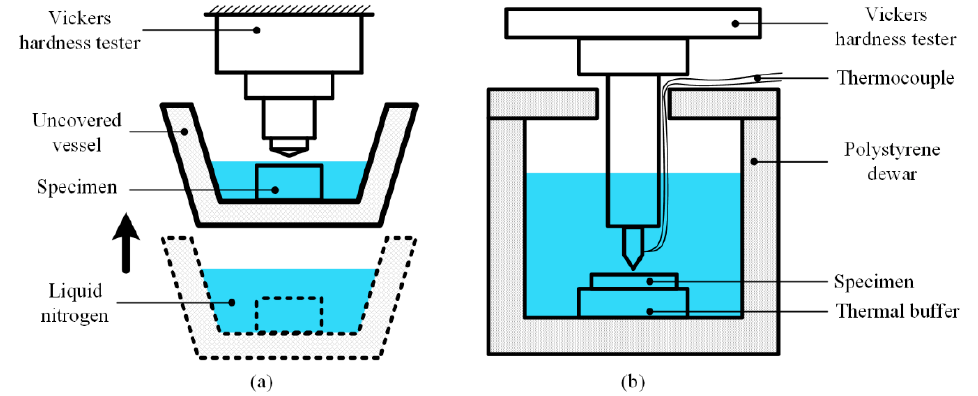
Figure 6. Schematic diagram of indentation test immersed in liquid nitrogen (LN 2 ). ( a ) Original setup. ( b ) Improved setup. ( b ) Improved